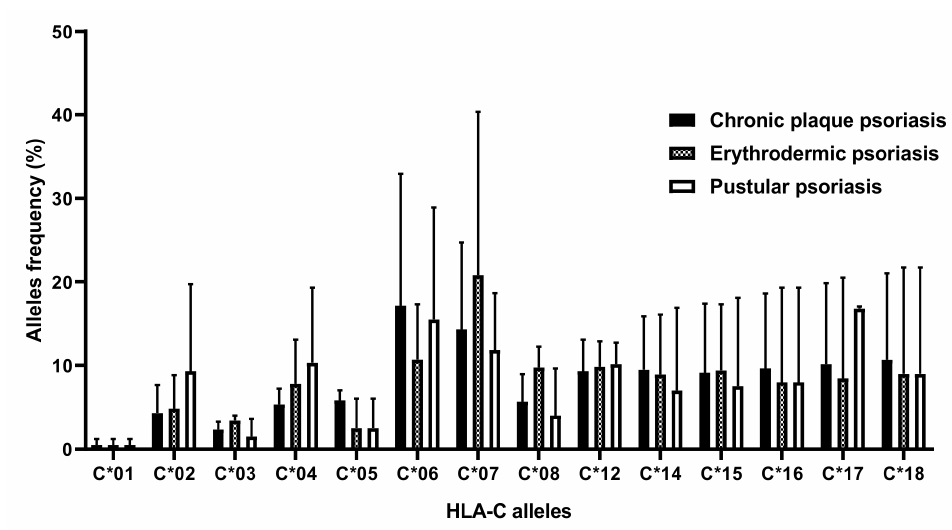
Figure 3. HLA-C allelic frequencies according to psoriasis clinical phenotypes.